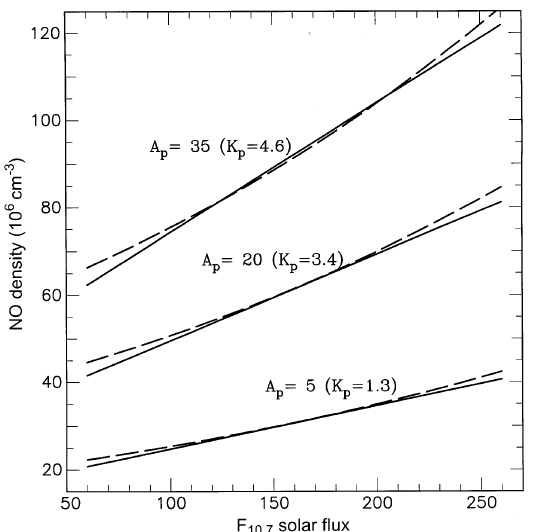
Fig. 2. Mean values for the peak NO density, at latitudes of 60 — 90 ° , as a function of solar flux and magnetic activity. Solid lines are from Eq. 4; this corresponds to the mean high-latitude results of Fesen et al . (1990) (at A (cid:112) + 17) increased by 35%. Broken lines give the expression D (cid:78)(cid:79) " exp(15.91 # 0.0032 F (cid:49)(cid:48)(cid:46)(cid:55) # 0.005 K (cid:112) ), derived from the work of Smith et al . (1993), decreased by 24%